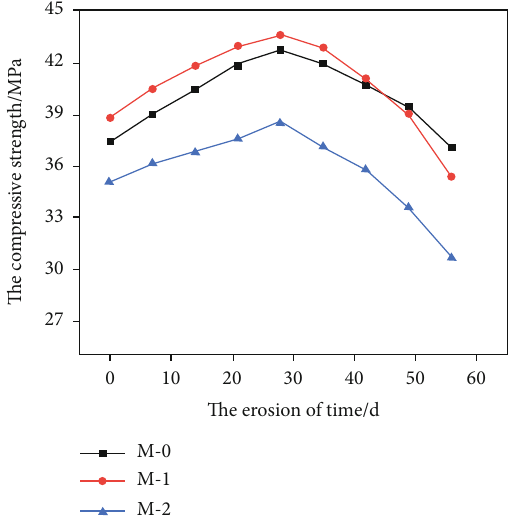
Figure 4: Variation curve of compressive strength of steel slag concrete with erosion